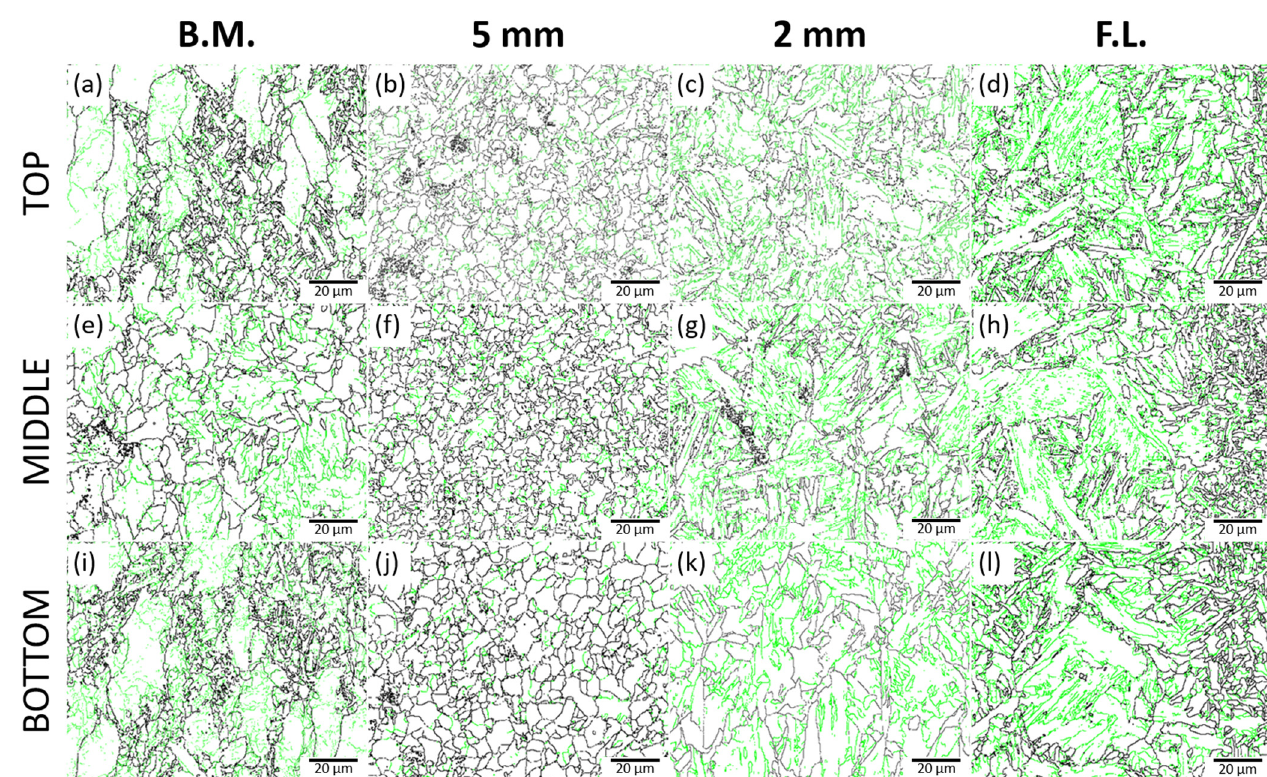
Figure 5. Grain boundary (GB) map of the base metal and HAZ: ( a ) base metal, ( b ) 5 mm from F.L., ( c ) 2 mm from F.L., ( d ) F.L. of top; ( e ) base metal, ( f ) 5 mm from F.L., ( g ) 2 mm from F.L., ( h ) F.L. of middle; ( i ) base metal, ( j ) 5 mm from F.L., ( k ) 2 mm from F.L., ( l ) F.L. of bottom. Table 5. Microstructure area fraction (%) and average grain size of base metal and HAZ.